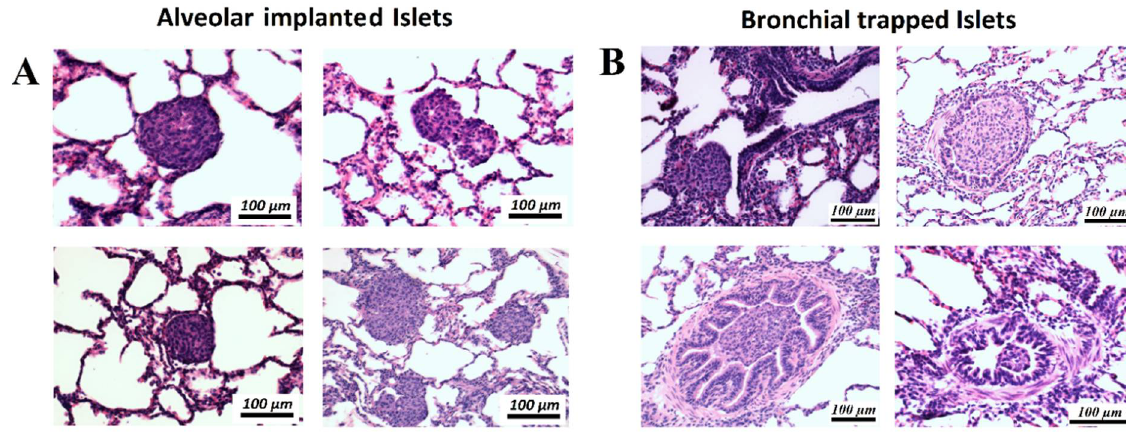
Figure 4. Histology (hematoxylin and eosin, H&E-staining) of implanted islets in different regions within the lung cavity. ( A ) Islets are either located in the alveolar cavity or at the center of a sacculus where multiple alveolar structures merge. (B ) Islets trapped in different locations within the small bronchial system with partial or complete obstruction of the bronchial airway.